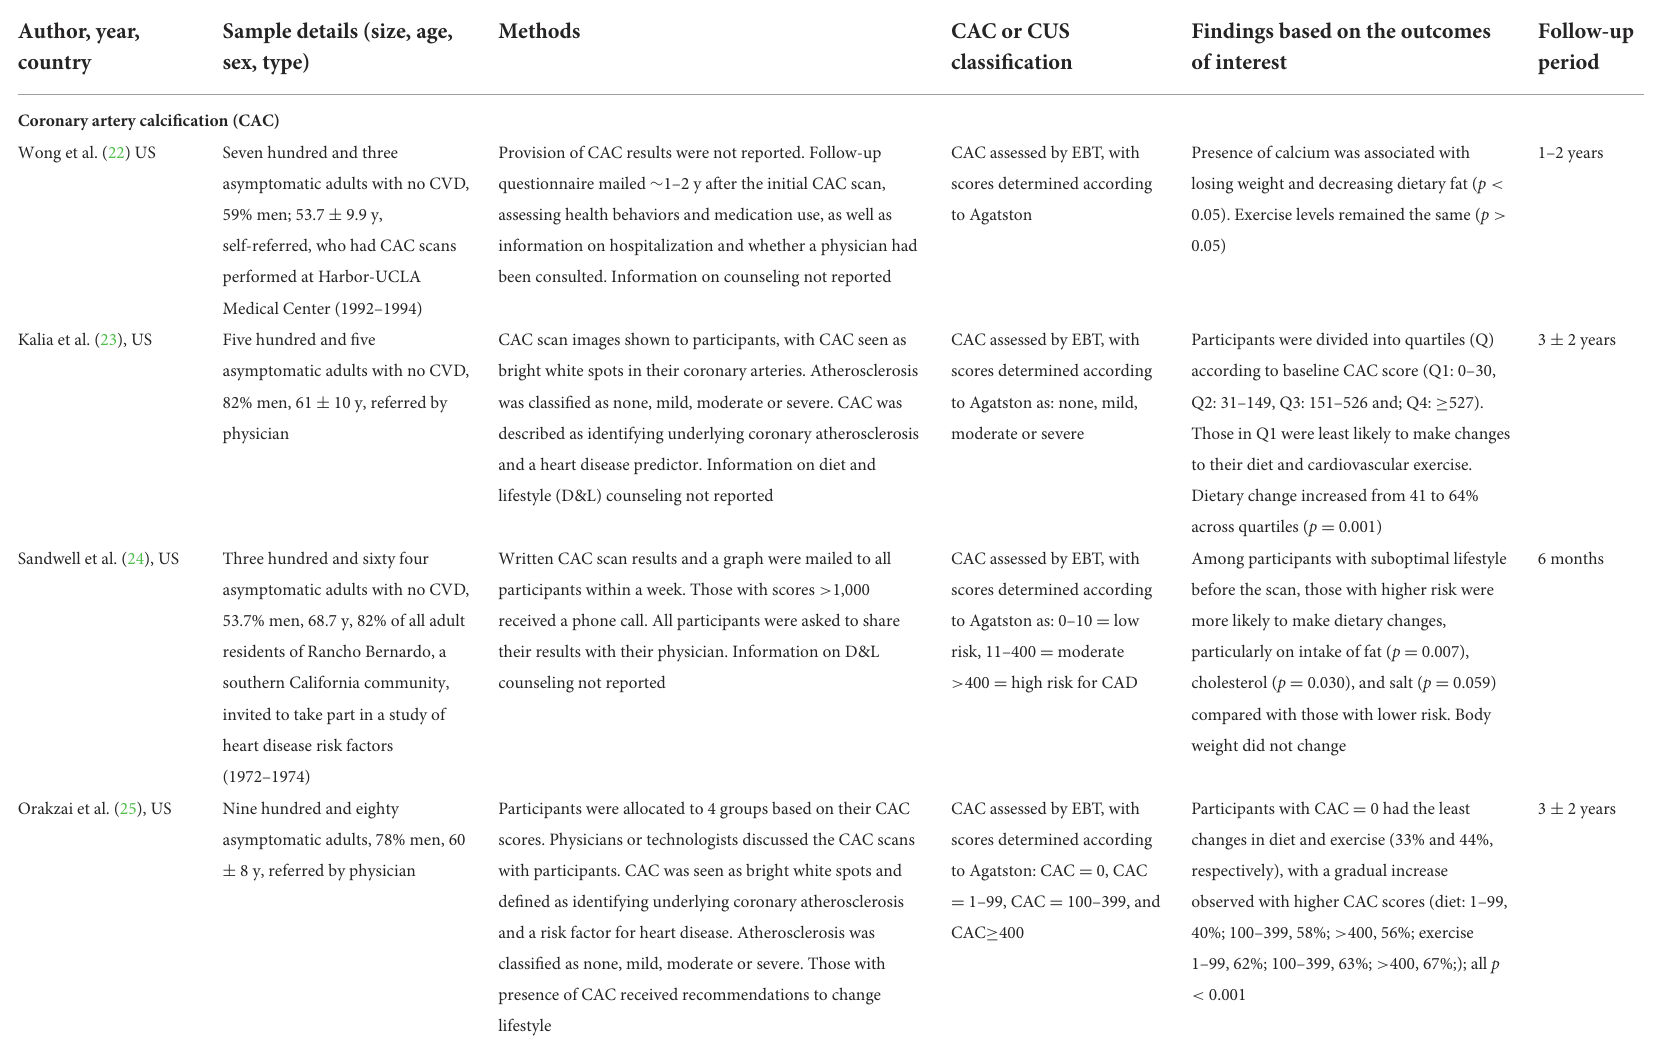
TABLE 2 Summary of observational studies on provision of CAC and CUS results and changes in diet, physical activity and anthropometric